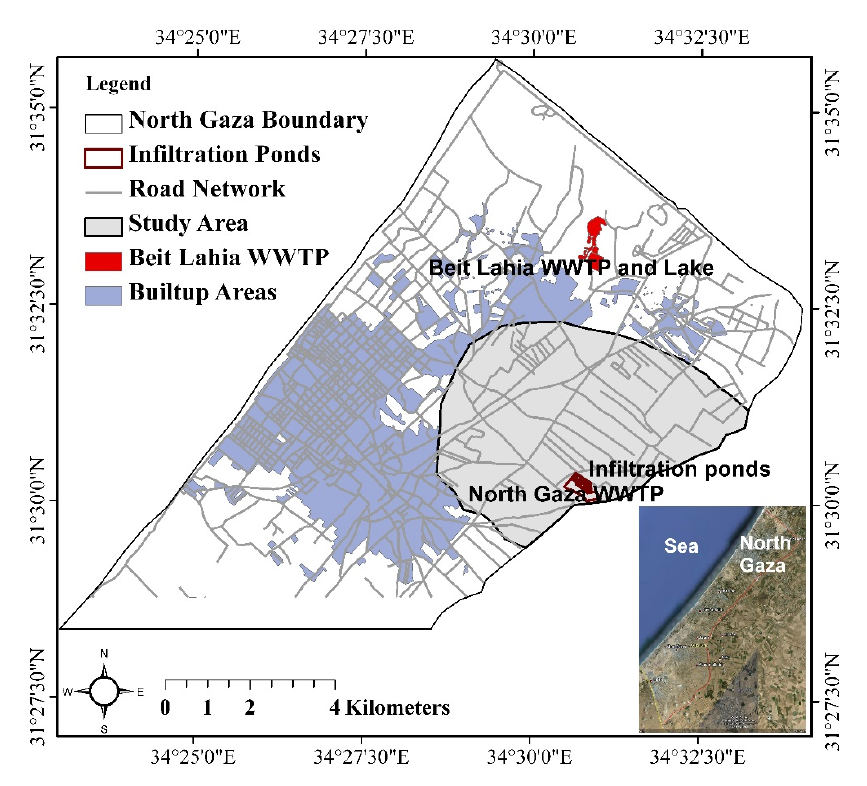
Figure 1. Study area map showing the wastewater treatment plants. Data source [9]. Inset picture from Google